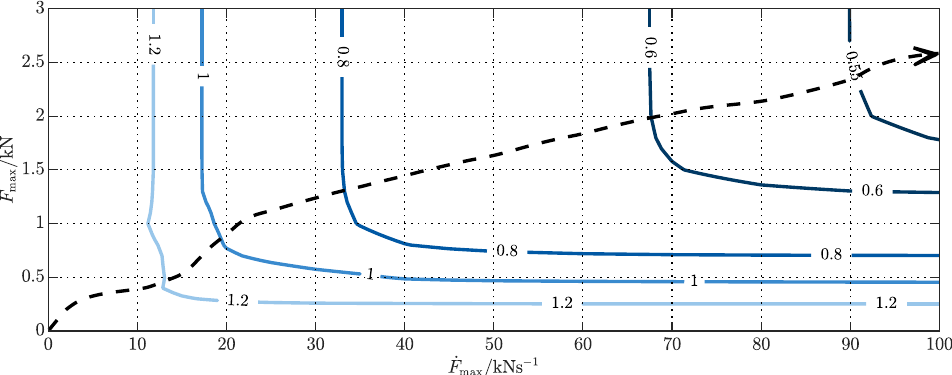
Figure 17. RMS body acceleration contour plot for the 90kmh − 1 BC profile